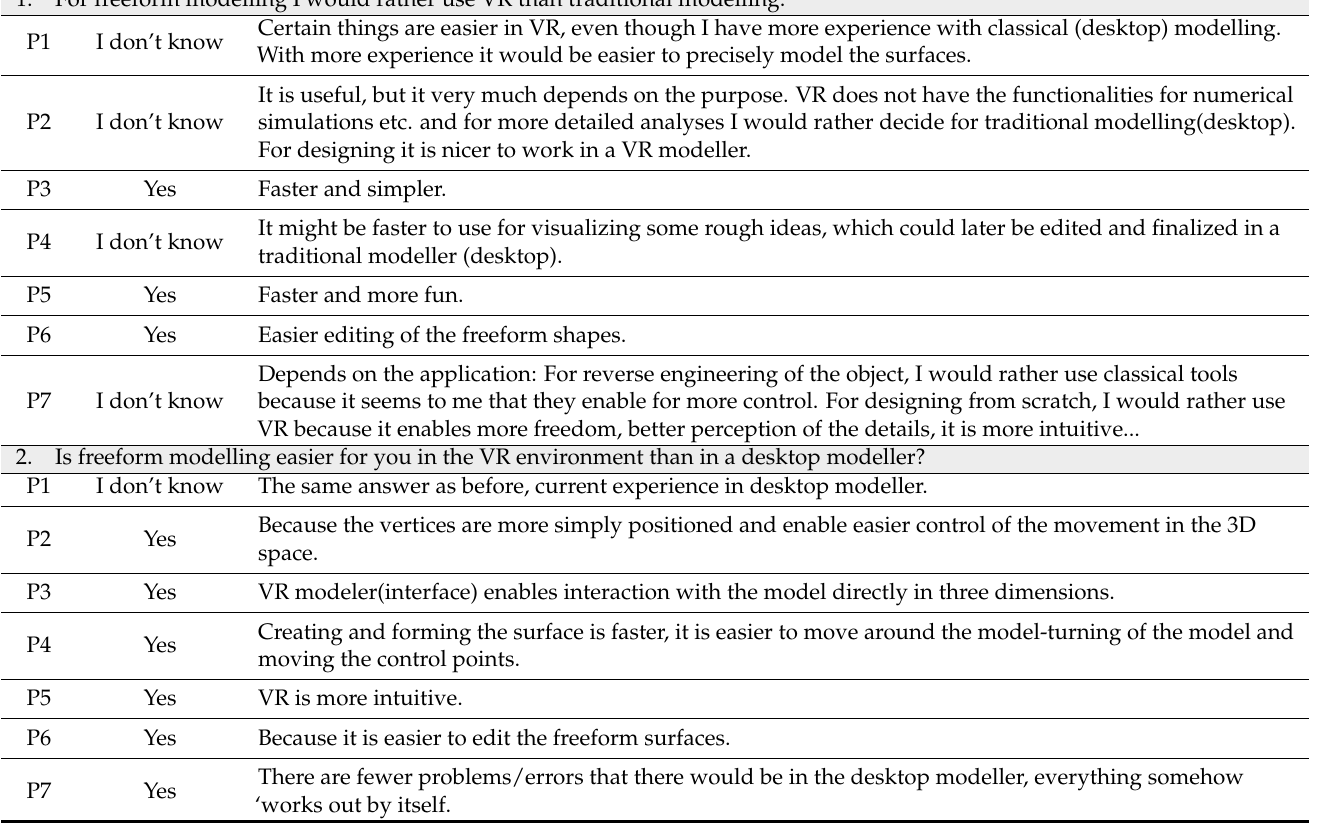
Table 6. Participants’ statements about 3D freeform modelling using VR